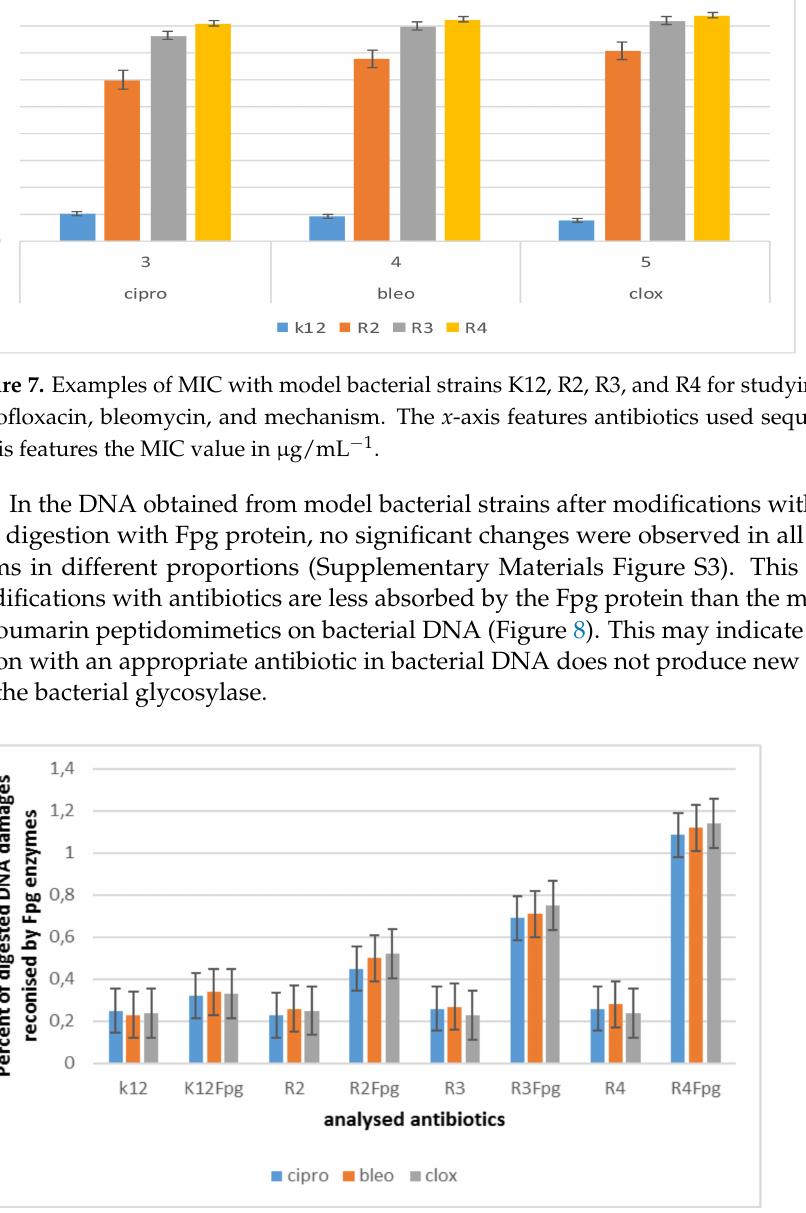
Figure 8. Percentage of bacterial DNA recognized by Fpg enzyme in model bacterial strains after ciprofloxacin, bleomycin, and cloxacillin treatment. The compounds were statistically significant at p <